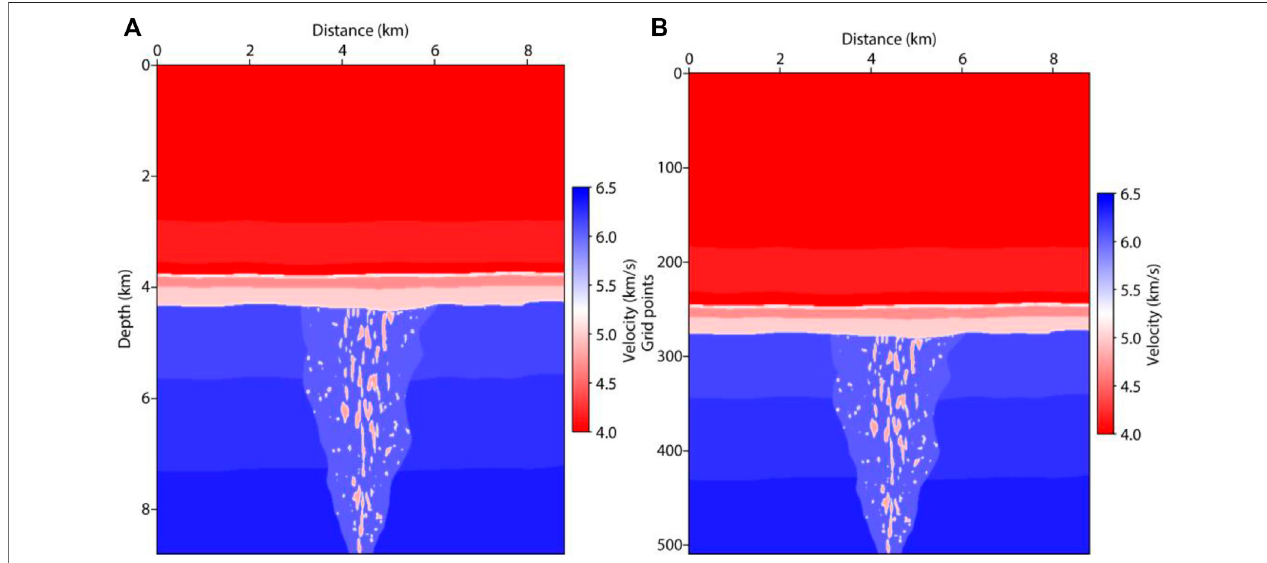
FIGURE 16 | Ultra-deep fault-karst carbonate reservoir model (A) and the resampled model (B) .